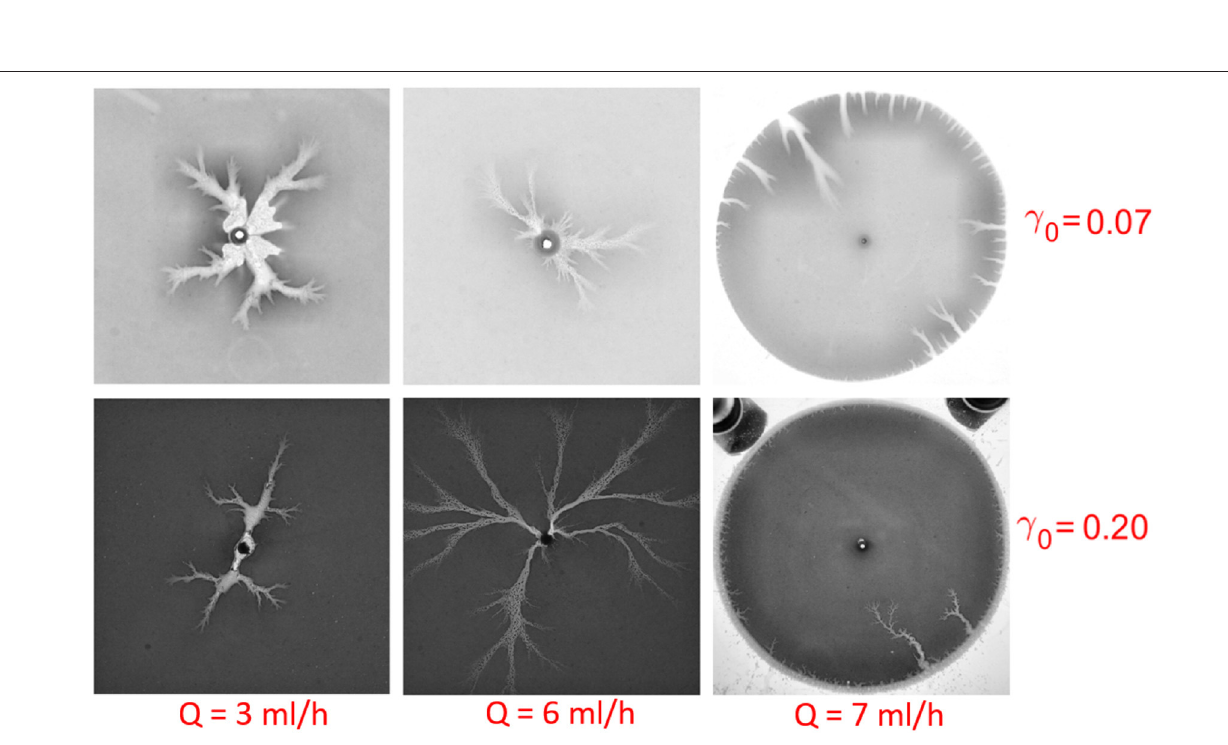
0.07 to = 3 ml / h ,6 ml / h ,7 ml / h , =